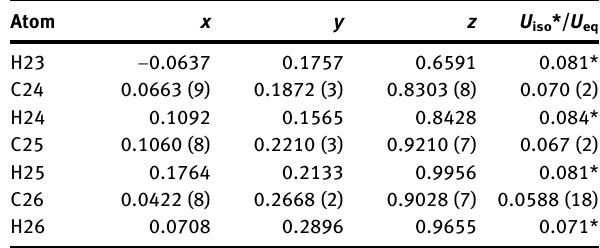
Table  : Fractional atomic coordinates and isotropic or equivalent isotropic displacement parameters (Å 